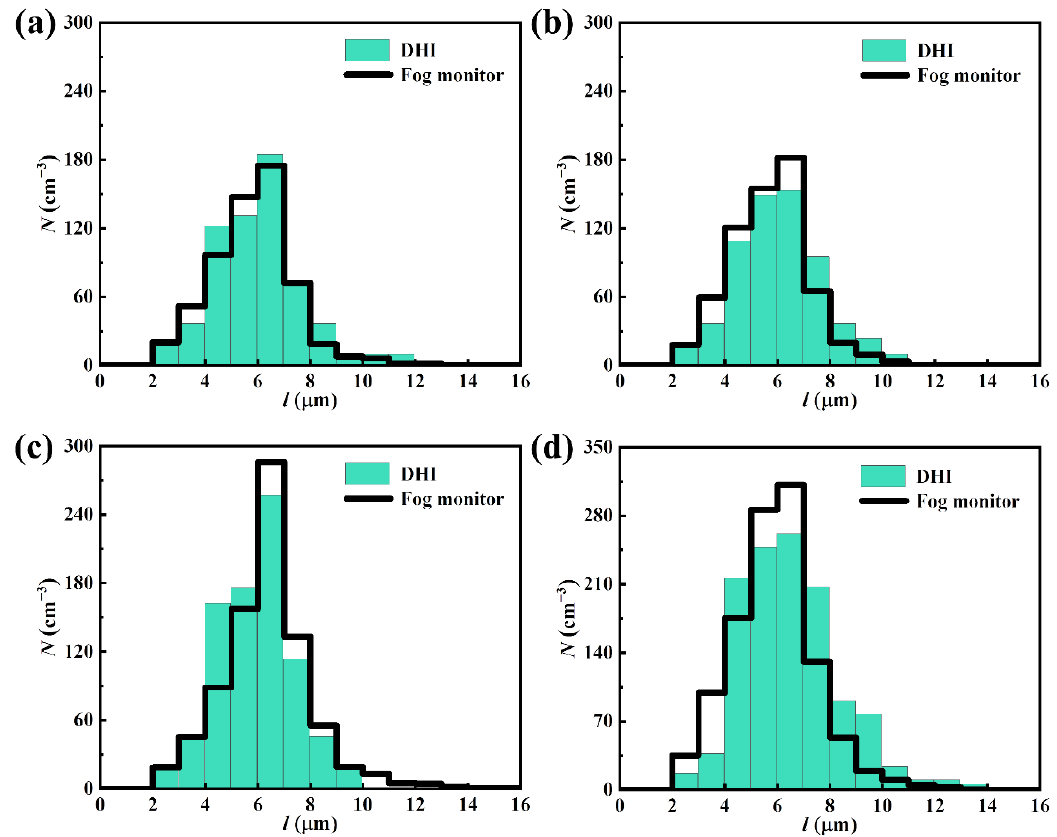
Figure 4. Comparison of DHI and fog monitor on the DSD. ( a ) Size distribution at 1.0 min. ( b ) Size distribution at 4.0 min. ( c ) Size distribution at 2.0 min. ( d ) Size distribution at 3.0 min.